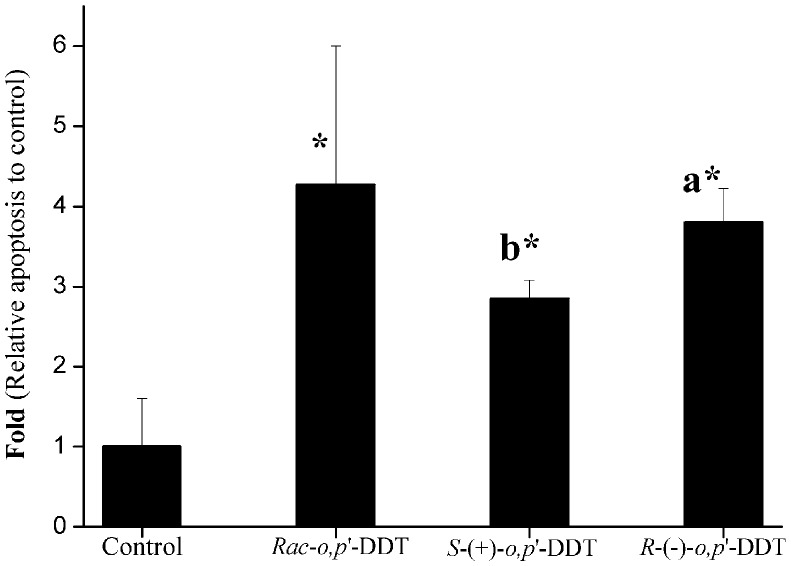
Enantioselectivity in DDT-inducted apoptosis in PC12 cell.The percent of early apoptotic cells following treatment with individual enantiomers or racemate of DDT was measured with flow cytometry quantified by Annexin V (AV)-PI staining.